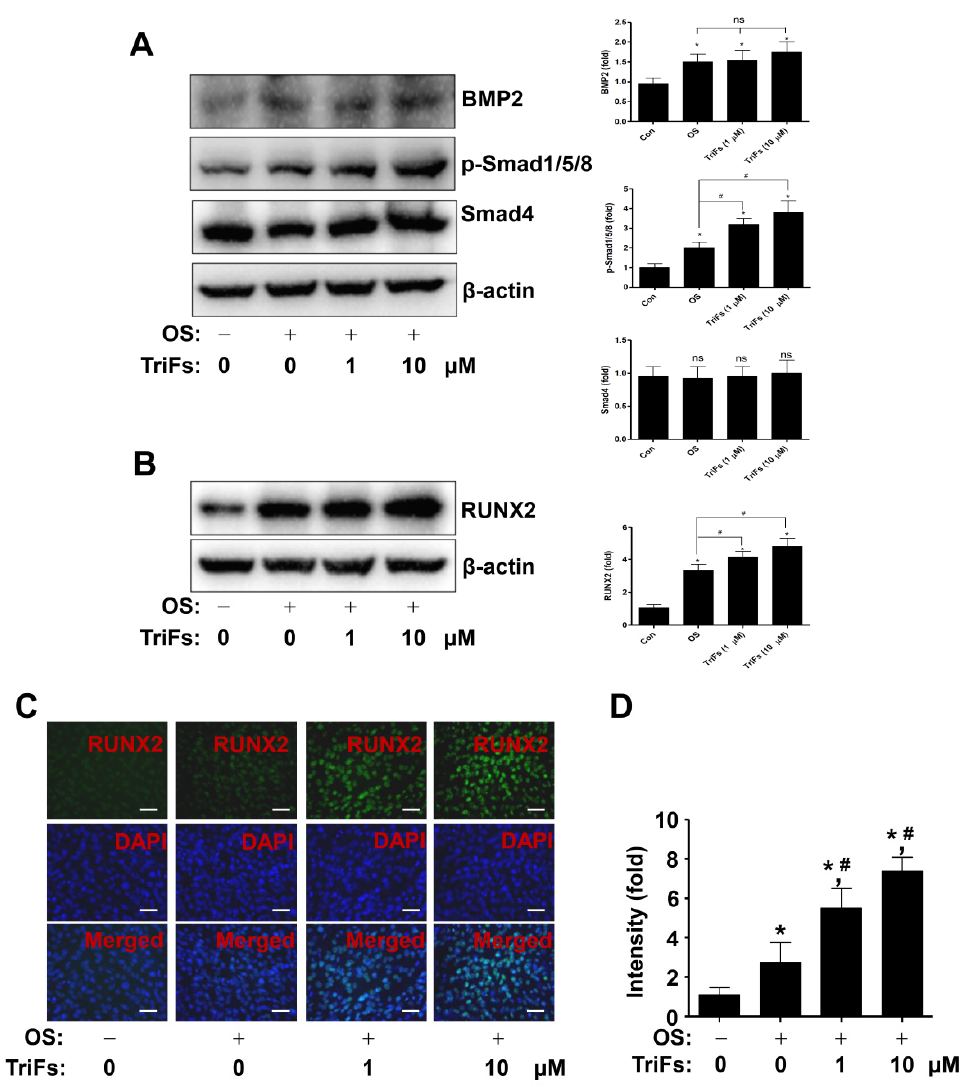
Figure 3. Osteogenic effects of trifloroside (TriFs) on BMP2 signaling molecules and RUNX2 in the nucleus. ( A , B ) BMP2, p-Smad1/5/8, Smad4 ( A ), and RUNX2 ( B ) were all probed in equal amounts using Western blotting. The values (fold) were normalized to β -actin and were displayed as a bar graph. ( C , D ) RUNX2 (green) and a nuclear marker DAPI (blue) were used to determine nuclear RUNX2 expression and accumulation, which was examined using fluorescence microscopy. The values (fold) are displayed as a bar graph ( D ). *, p < 0.05 indicates significant differences when compared to the control. #, p < 0.05 indicates significant differences when compared to OS. Data are presented as mean ± standard error of the mean (S.E.M.). ‘ns’, not significant. Data shown are from three independent trials. Scale bar: 50 µ